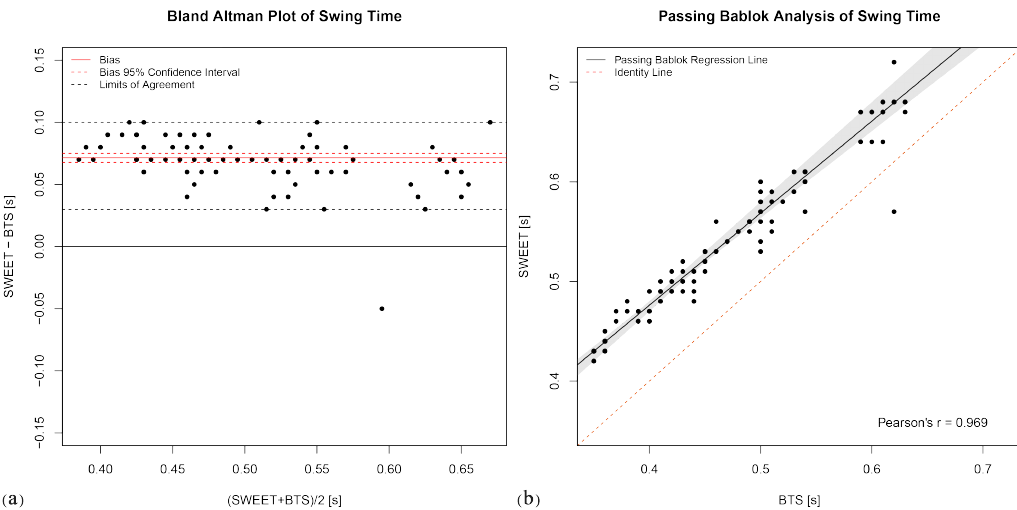
Figure 9. Swing Time: ( a ) Bland–Altman plot; ( b ) Passing–Bablok regression